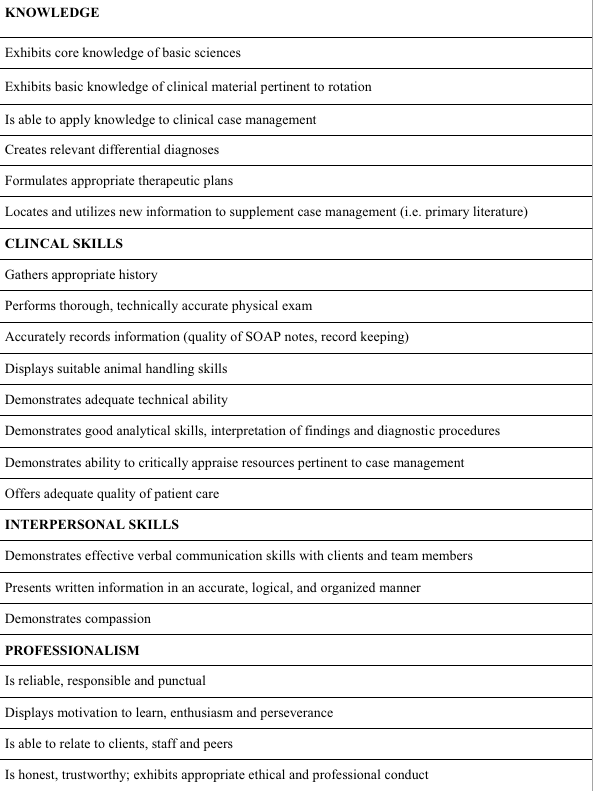
log of procedures performed (22). The goal is to improve skills while performing specific procedures with the emphasis on the procedures themselves without much feedback given for competencies such as communication or